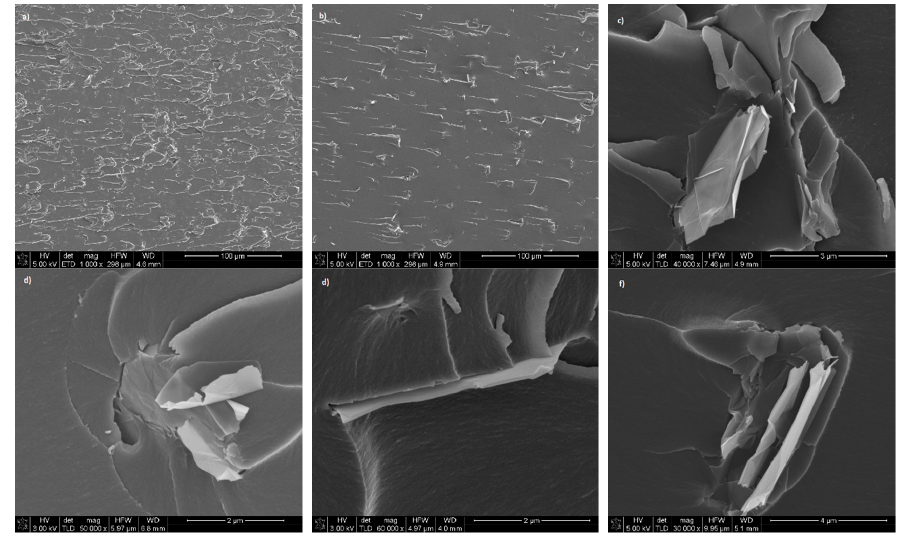
Figure 3. FEG-SEM micrographs of epoxy composites reinforced with GNP1 ( a , c ); GNP 2 ( d ), GNP3 ( e ) and GNP4 ( b , f